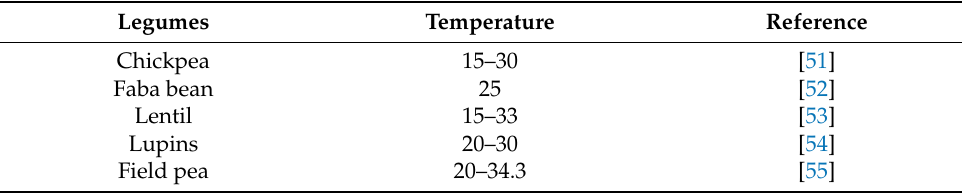
Table 2. Threshold temperature for cool-season food legumes.